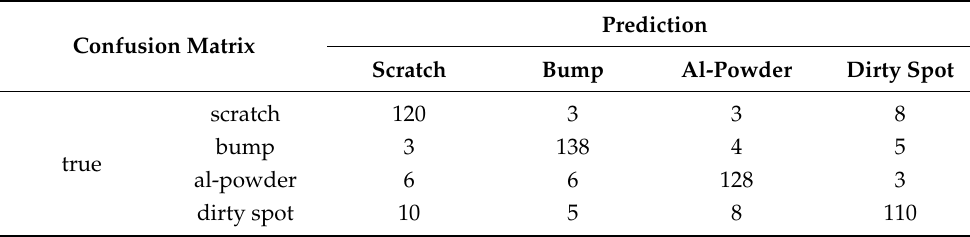
Table 3. Four-classification confusion matrix of ResNet101 network model.